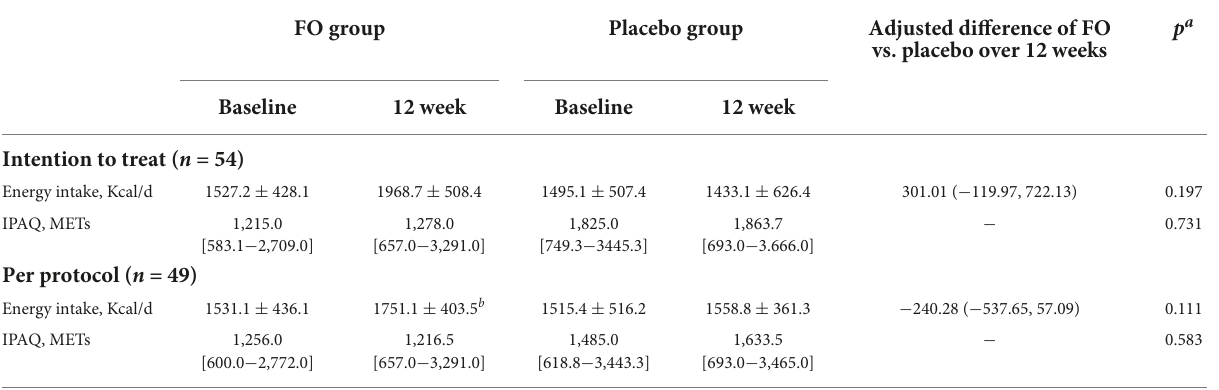
TABLE 2 Energy intake and physical activity between the two groups for 12